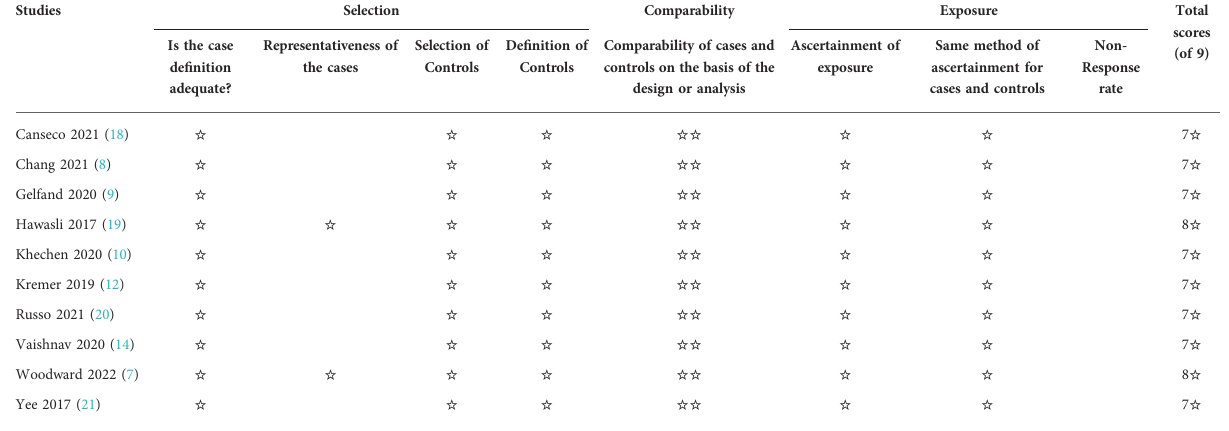
TABLE 2 Quality assessment of the included